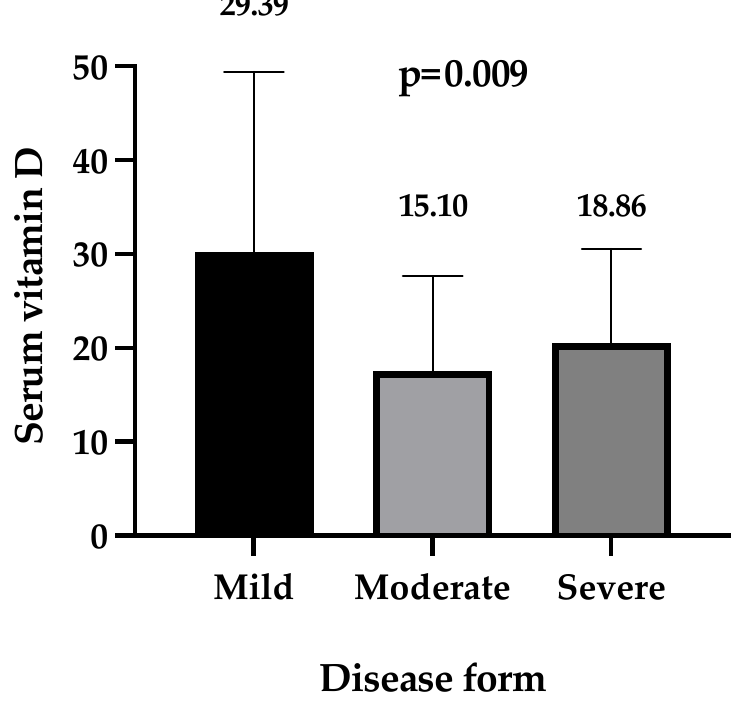
Figure 2. Serum levels of vitamin D in different disease severity. Results were analyzed with the Kruskal–Wallis test and Dunn’s for multiple comparisons groups. Box plot (median and interquartile range), the horizontal lines represent the 75% percentile, and the top of the box plot is the me- dian.